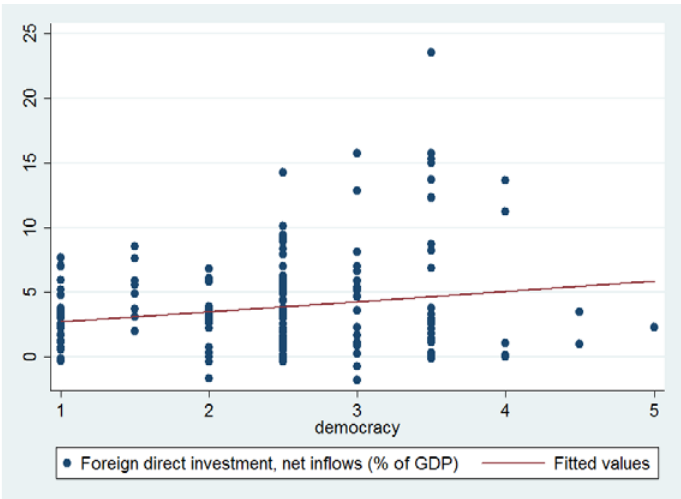
Figure 3: Democracy and FDI in the Arab world